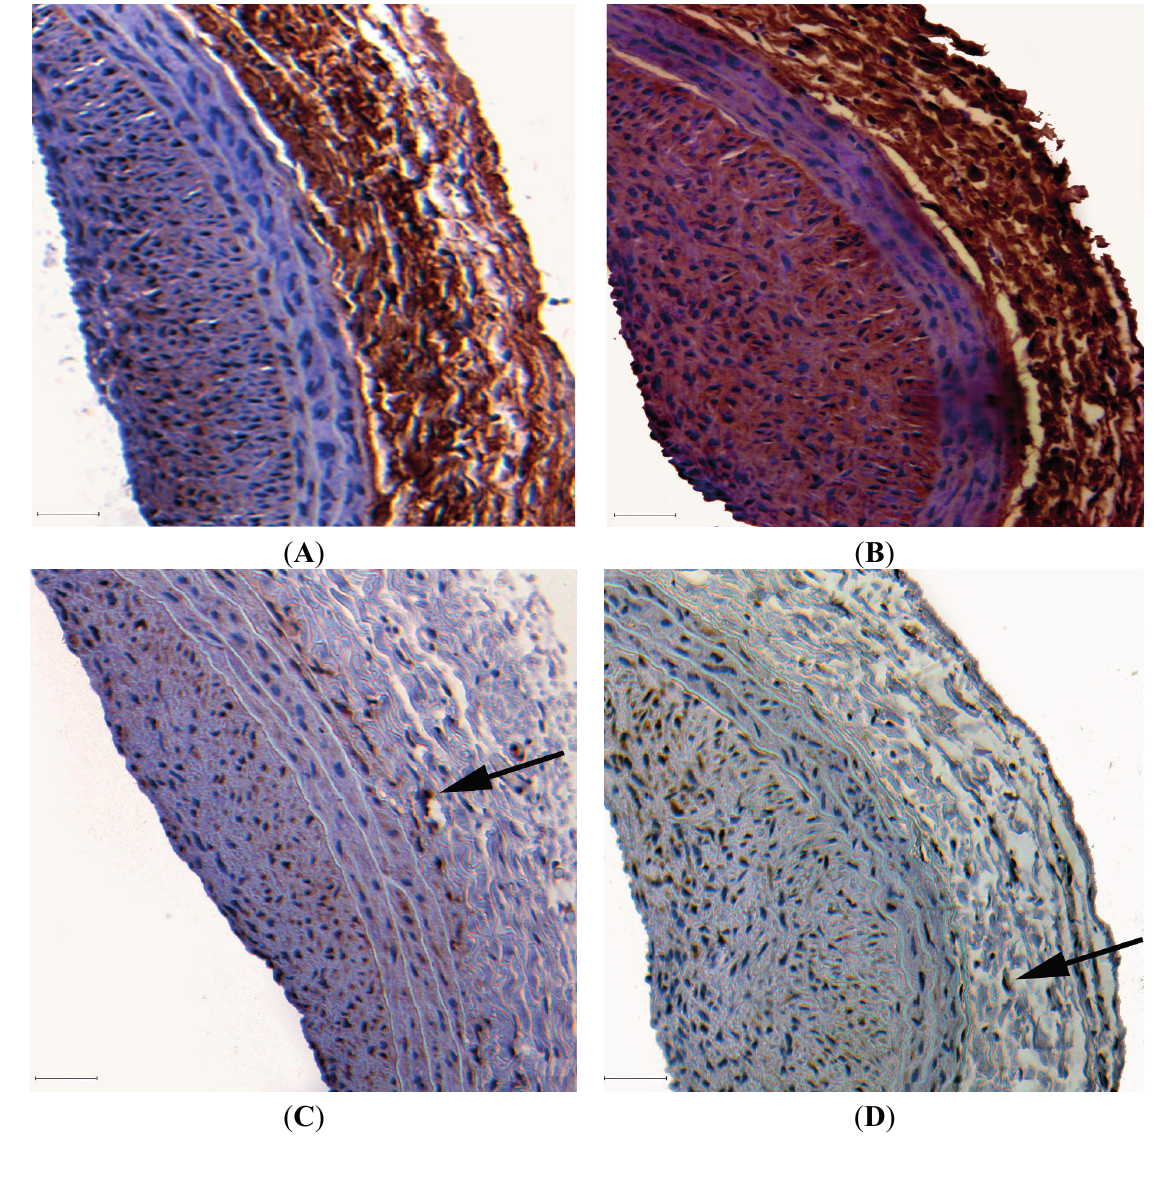
Figure 2. Effect of homocysteine on the expression of collagen type 1 ( A , B ) and AT 1 R ( C , D ) in adventitia of balloon-injured arteries; scale bars = 50 μ m. Immunohistochemical staining shows the expression of collagen type 1 and AT 1 R in both control group and HHcy group at day 28 following injury (( A , C ) the control group; ( B , D ) the HHcy group ×200)); ( E ) Optical density of adventitial collagen type 1 staining in each group at different time points; and ( F ) Percentage of AT 1 R positively stained cell in the adventitia. Δ p < 0.05, ΔΔ p < 0.01 versus normal artery with control diet; # p < 0.05, ## p < 0.01 versus normal artery with methionine diet; * p < 0.05 versus control group of the same time